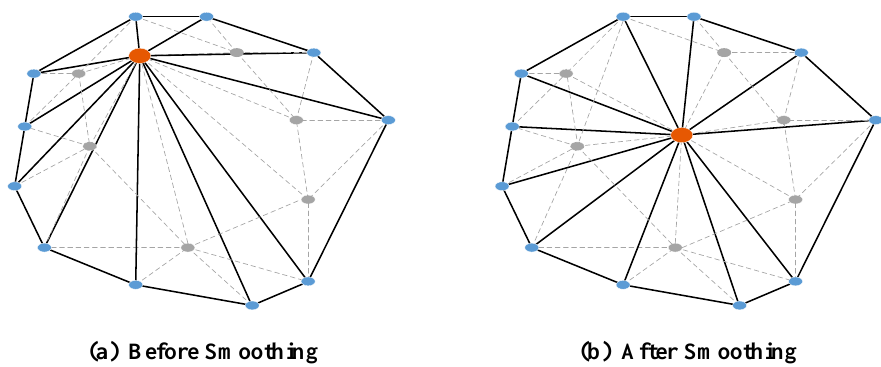
Figure 1. A simple illustration of improving tetrahedral mesh quality using Laplacian